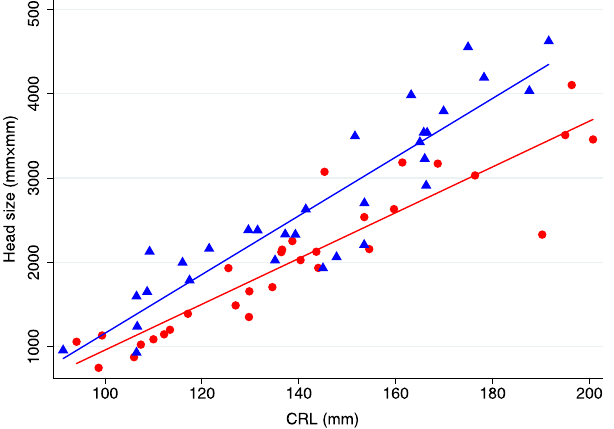
Figure 2. Head size (mm 2 ) as a function of CRL (mm) in Japanese monkey fetuses pre- and post-NNP disaster (n = 62). The figure shows regressions between head size and CRL in pre- and post-disaster groups. Blue triangles were pre-disaster monkey fetuses with the blue line representing the fitted values (n = 31); R 2 = 0.85. Red circles were post-disaster monkey fetuses with the red line representing the fitted values (n = 31); R 2 = 0.84.